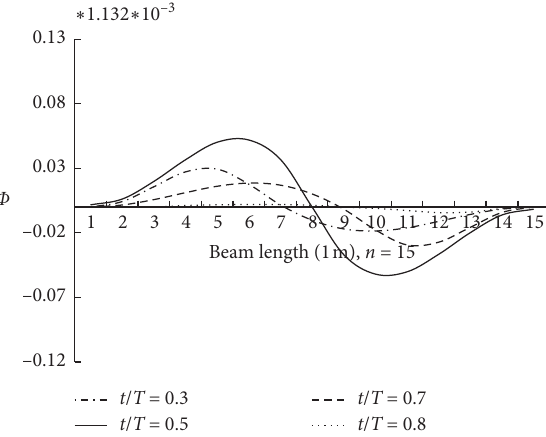
Figure 12: C-C Beam (1) deflection, F �